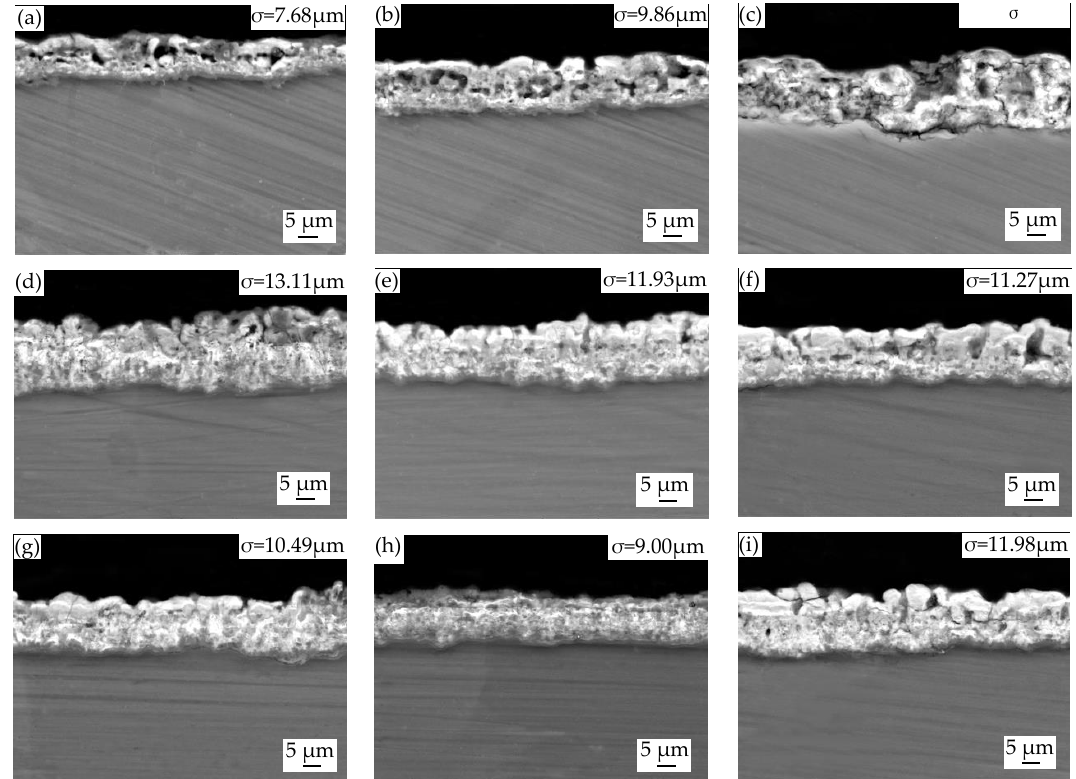
Figure 5. SEM images of cross-sectional morphology of coatings formed in different parameters: ( a – i ) are 1 # –9 # ,